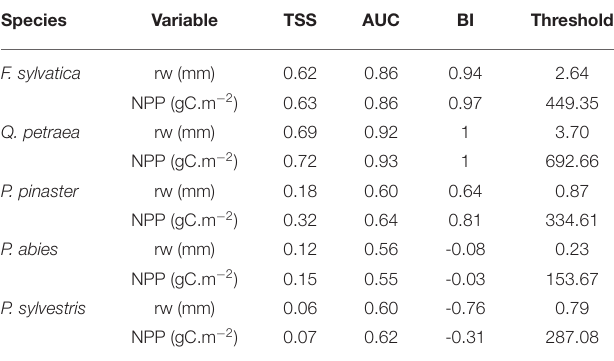
TABLE 1 | Model evaluation based on the prediction of species distribution. Species